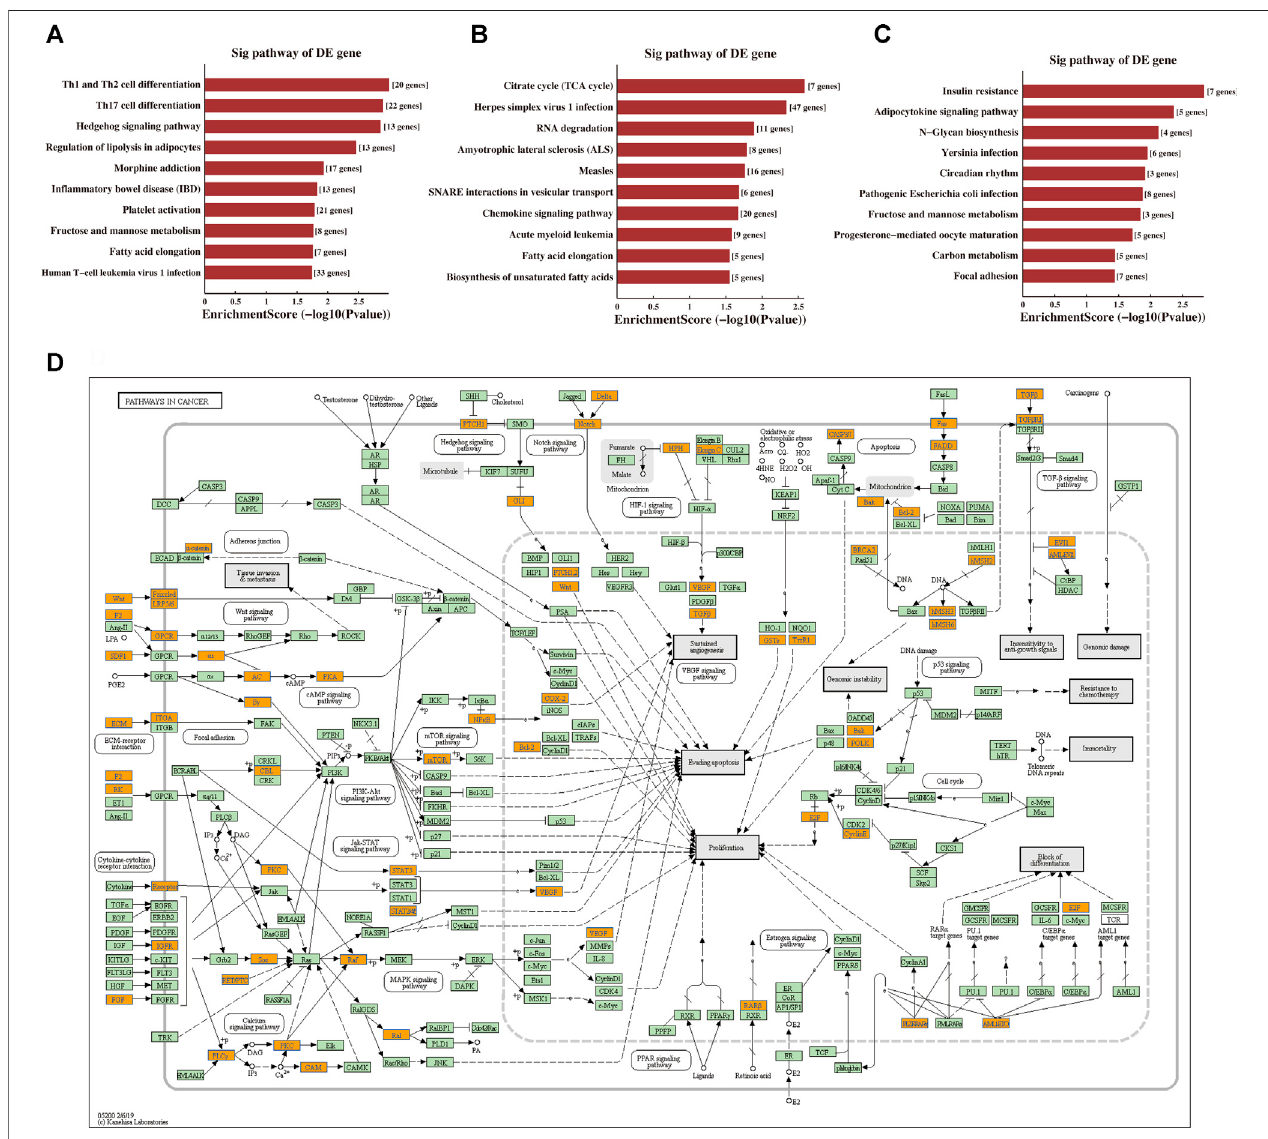
FIGURE 6 | Prediction of signaling pathways of tRF-1:28-Val-CAC-2, tRF-1:24-Ser-CGA-1-M3, and tRF-55:76-Arg-ACG-1-M2. Kyoto Encyclopaedia of Genes and Genomes (KEGG) pathway analysis for (A) tRF-1:28-Val-CAC-2, (B) tRF-1:24-Ser-CGA-1-M3, and (C) tRF-55:76-Arg-ACG-1-M2-targeting genes. The vertical axis shows the annotated functions of the target genes. The horizontal axis shows the enrichment score (-log10 transformed p -value) and the gene number of each cluster,respectively. TheKEGG pathwayswereconsidered signi fi cantif p -value < 0.05. Onlythetop10signi fi cantlyenriched clustersareincluded. (D) Mappingof pathways in cancer. Orange-marked nodes correspond to target mRNAs from tRF-1:28-Val-CAC-2.